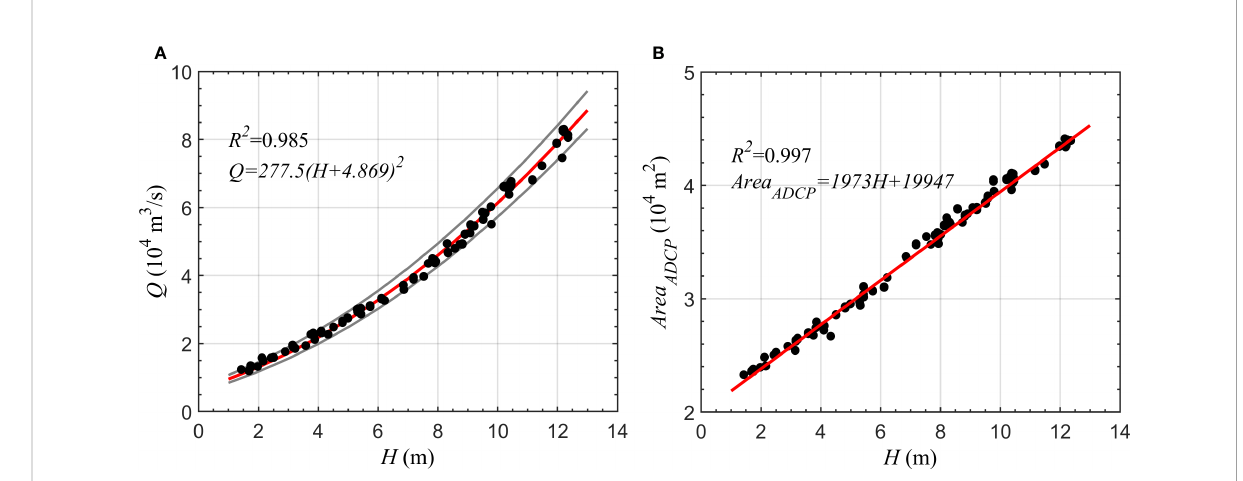
FIGURE 4 Index velocity relationship of u CAT and u ADCP